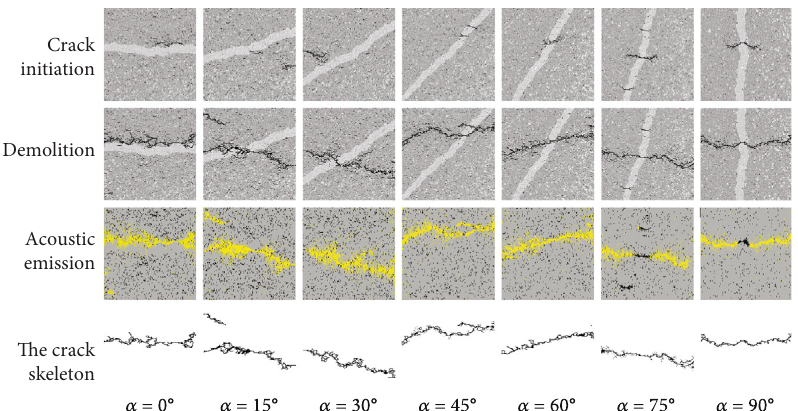
Figure 13: Uniaxial tensile damage evolution of shale under di ff erent azimuth angles.